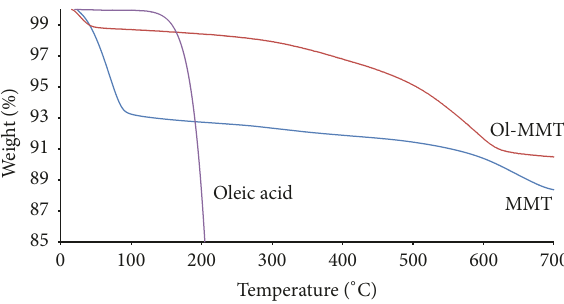
Figure 5: TGA results of oleic acid, MMT, and ol-MMT.